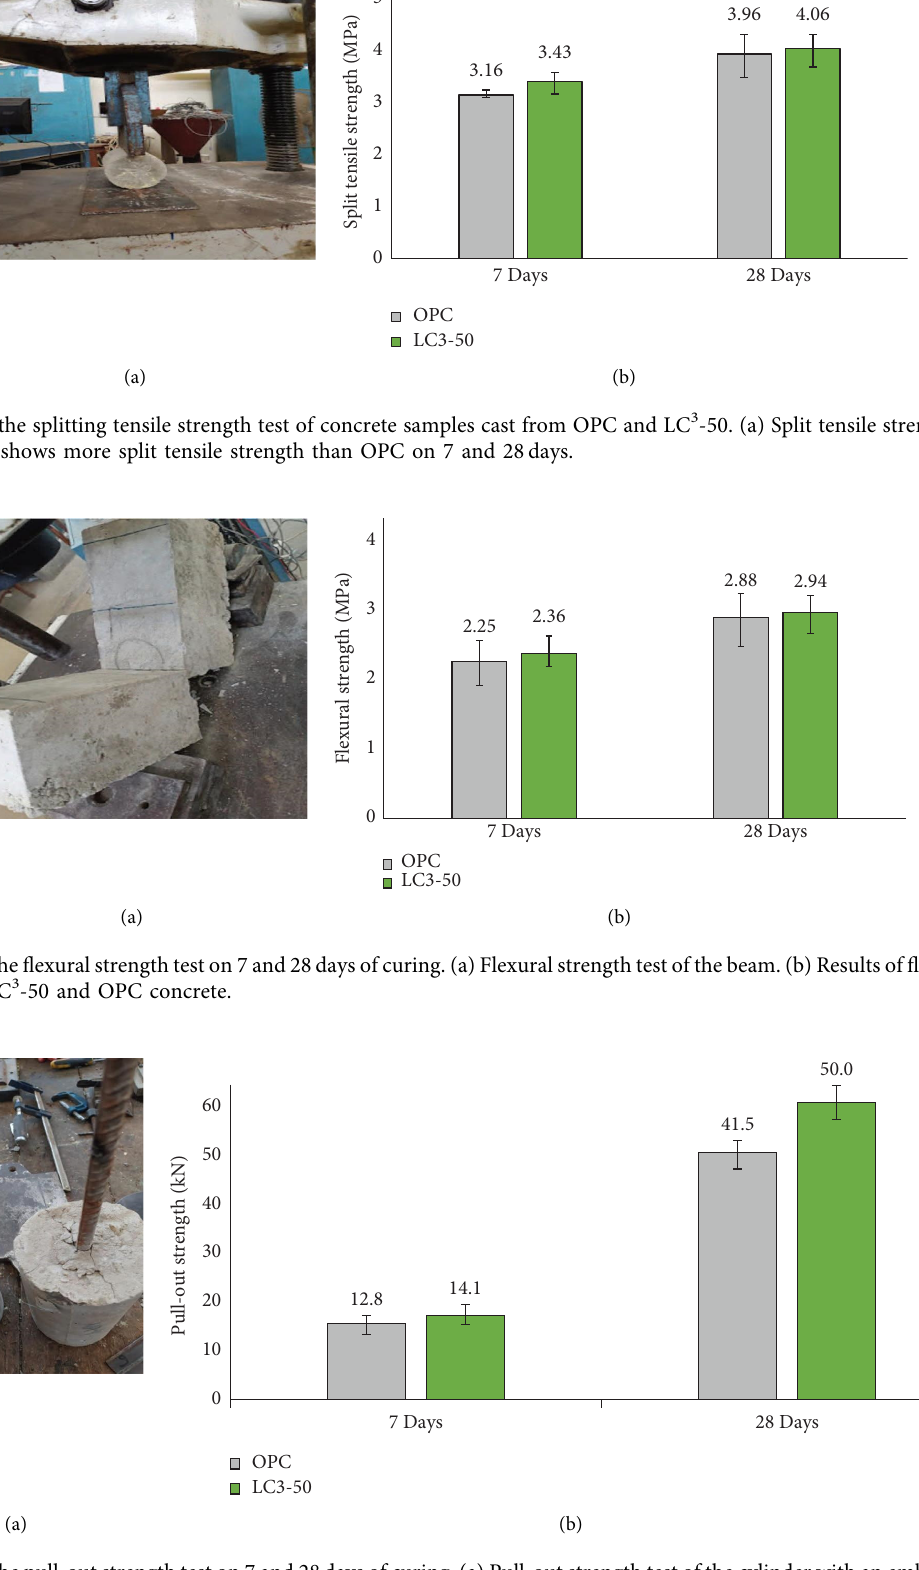
Figure 5: Results of the pull-out strength test on 7 and 28days of curing. (a) Pull-out strength test of the cylinder with an embedded rod. (b) Results of pull-out strength cast from LC 3 -50 and OPC